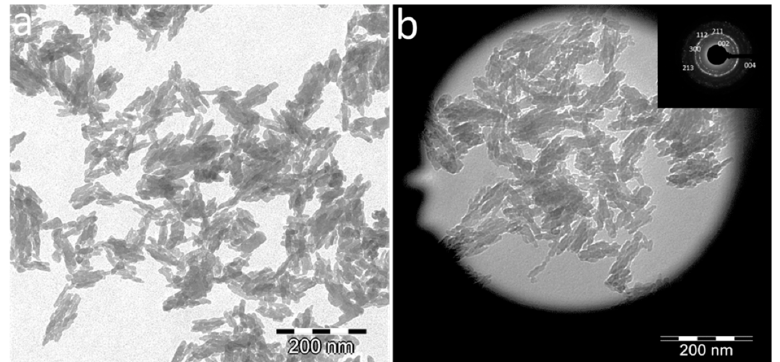
Figure 1. ( a ) TEM micrograph of Eu:cit-cAp nanocarriers prepared by thermal decomplexing of Ca/Eu/citrate/phosphate/carbonate solutions [27]; ( b ) selected area of the microgrid showing the nanoparticles for electrons diffraction, and SAED pattern (inset) showing the main reflections of the apatitic phase, i.e., 002, 211, 112, 300, 213, 004.